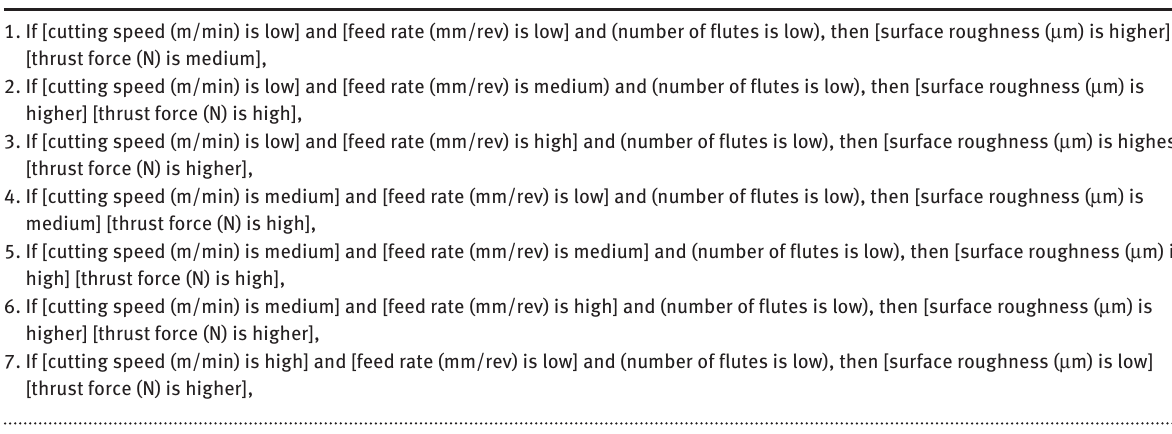
Table 2 Fuzzy logic rules in linguistic